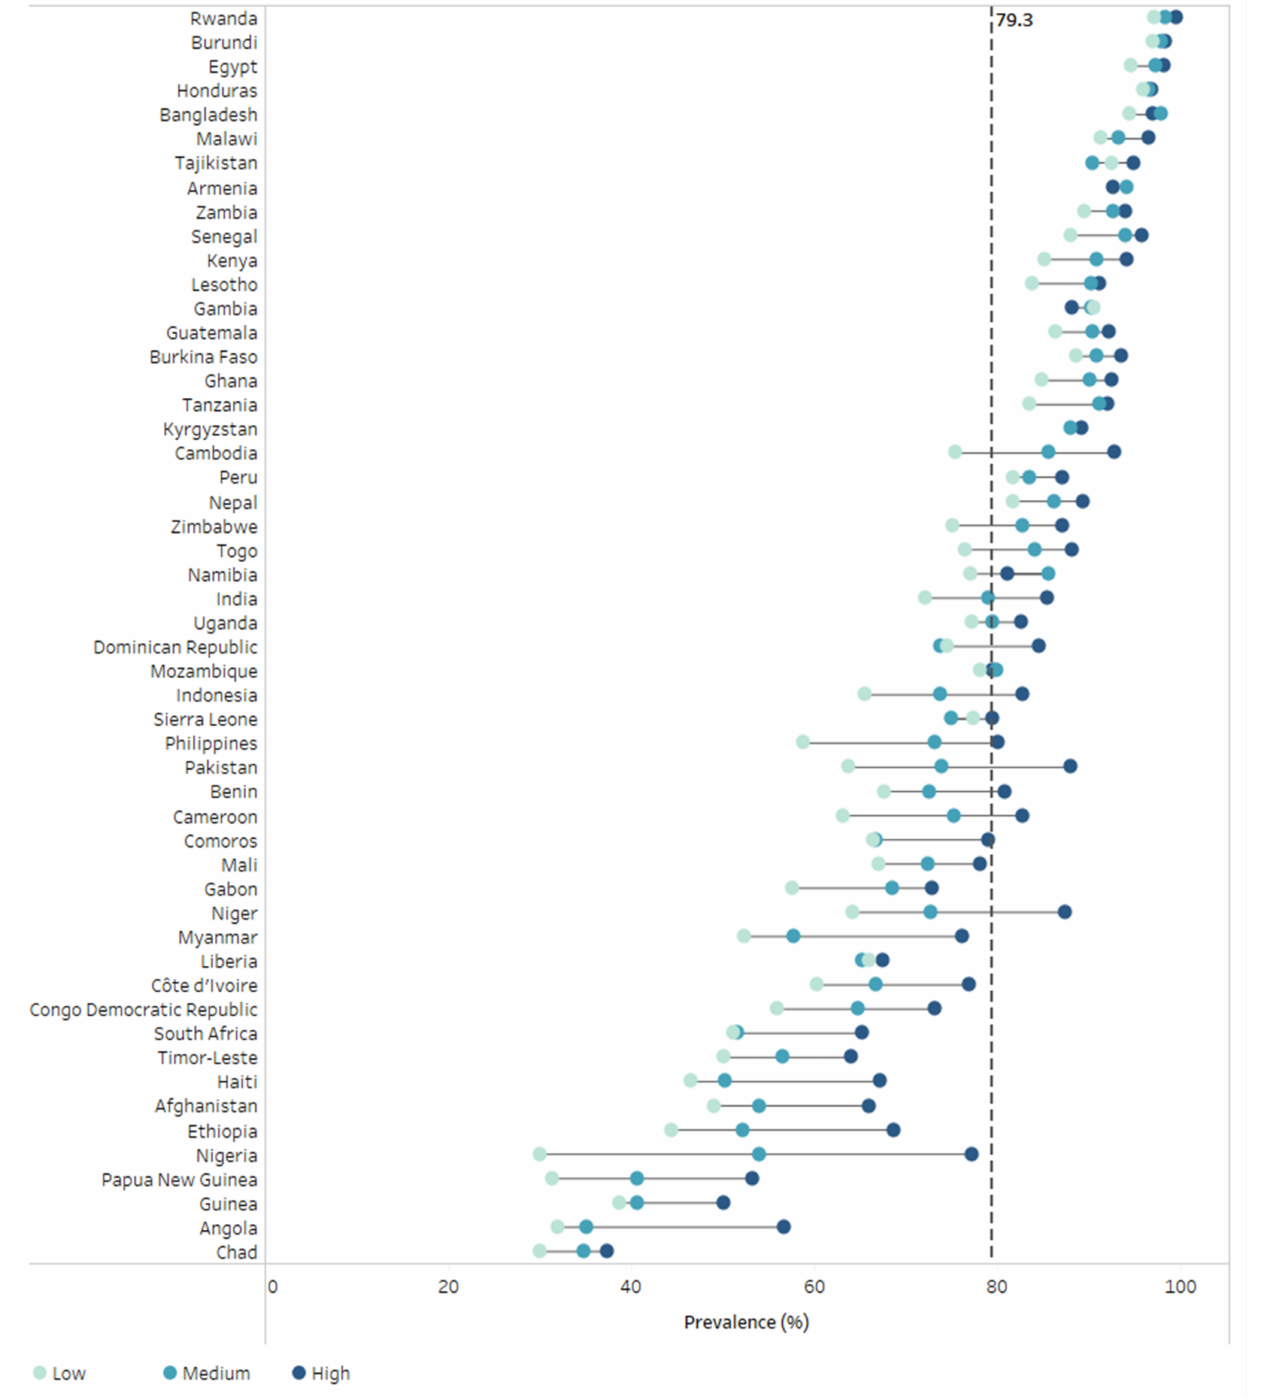
Figure 1. DTP3 immunization coverage by social independence tertile in 52 countries (DHS 2010–2019). Colored circles indicate social independence tertiles within each country. The black vertical dashed line indicates the median national coverage across 52 countries. DHS = Demographic and Health Surveys. DTP =